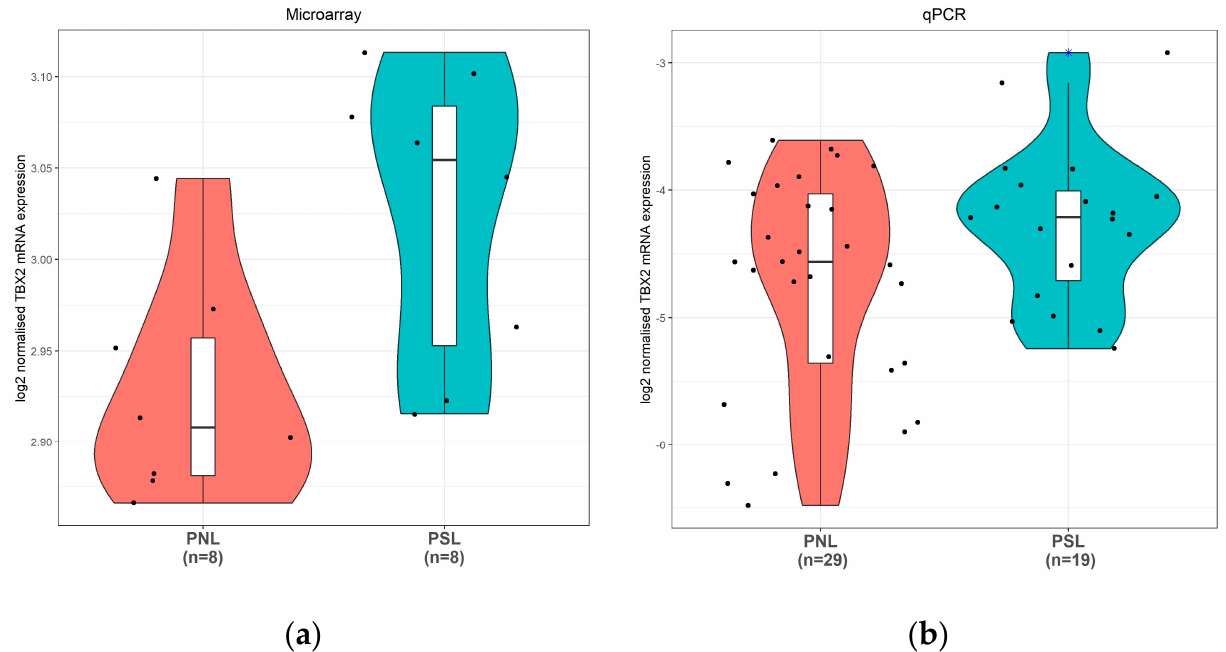
Figure 4. TBX2 mRNA expression in human preterm myometrial samples. ( a ): TBX2 mRNA expression measured by Illumina microarray profiling (* t -test p value < 0.05). ( b ): TBX2 mRNA expression measured by quantitative polymerase chain reaction (qPCR) (* t -test p value < 0.05). Dots indicate individual data points. The width of the density curves corresponds to the frequency of the observations. The box and whisker plot in the center with a median represents the interquartile range and the 95% confidence intervals. PNL: Preterm no labour; PSL: Preterm spontaneous labour.